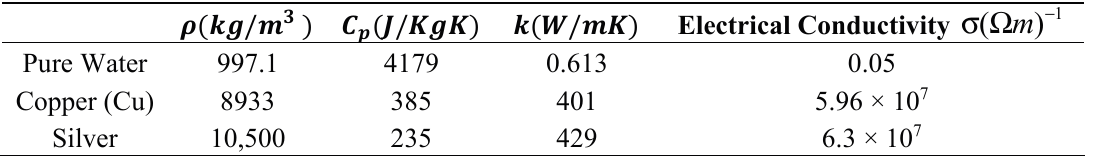
Table 1. Thermophysical properties of water, copper and silver nanoparticles